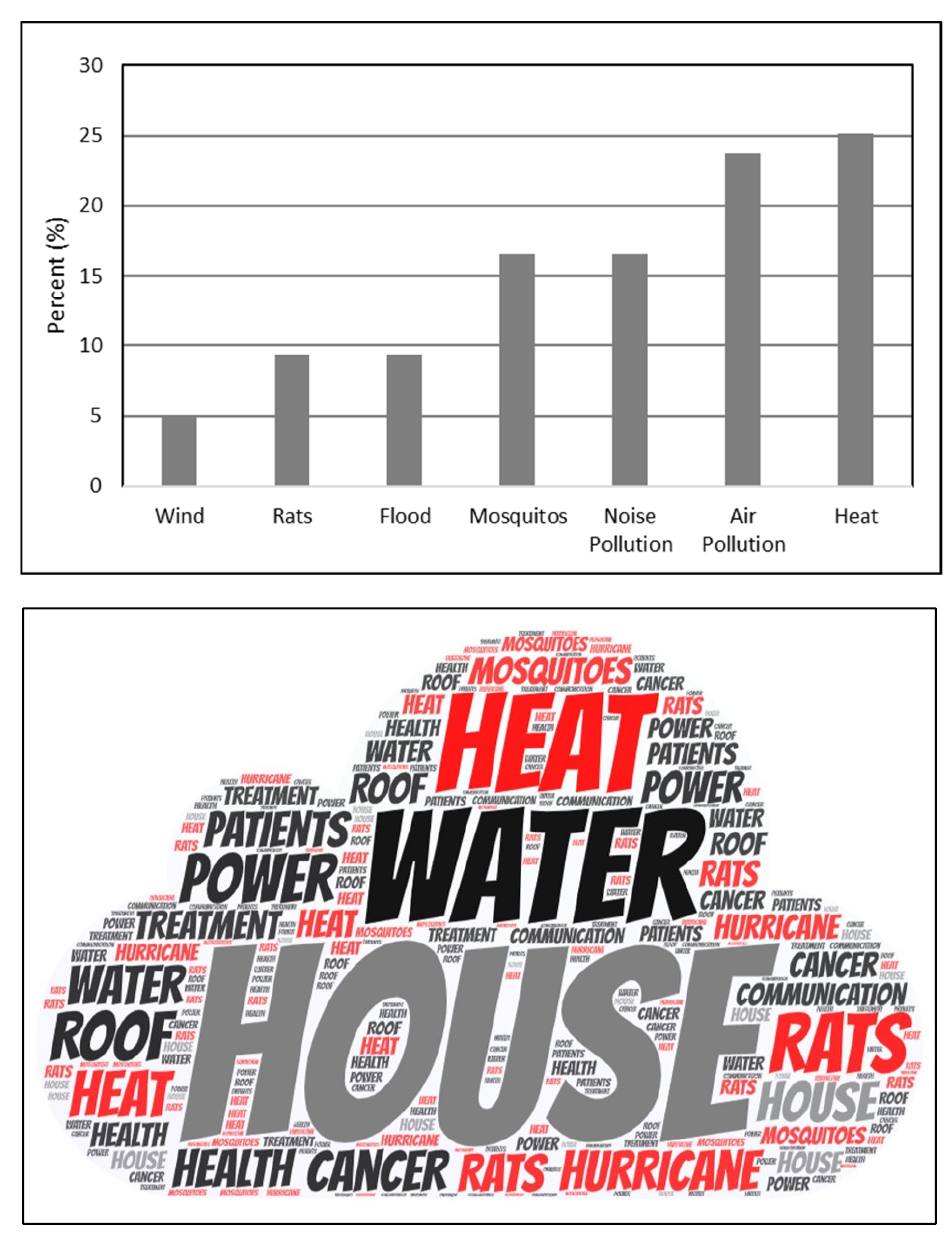
Figure 3. Upper Panel. Percentage of environmental stressors identified by cancer patients and health providers in the aftermath of Hurricane Mar í a and codified in transcripts. Lower panel: Wordcloud atlas of environmental stressors.